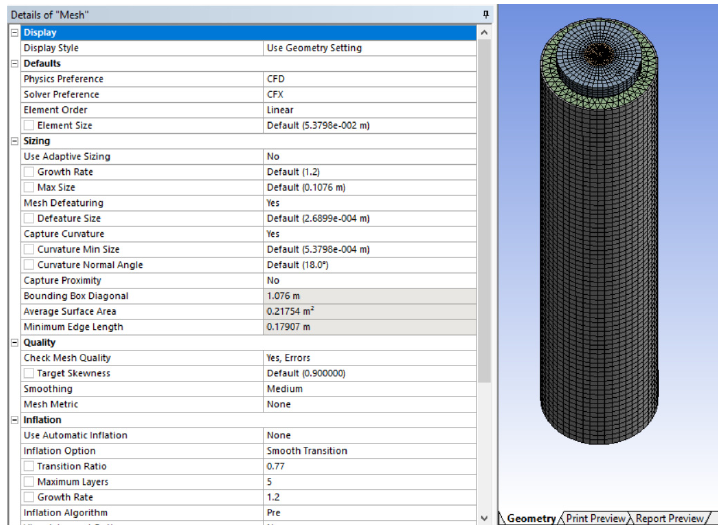
Figure A2. Characteristics of the mesh used in the modeling .